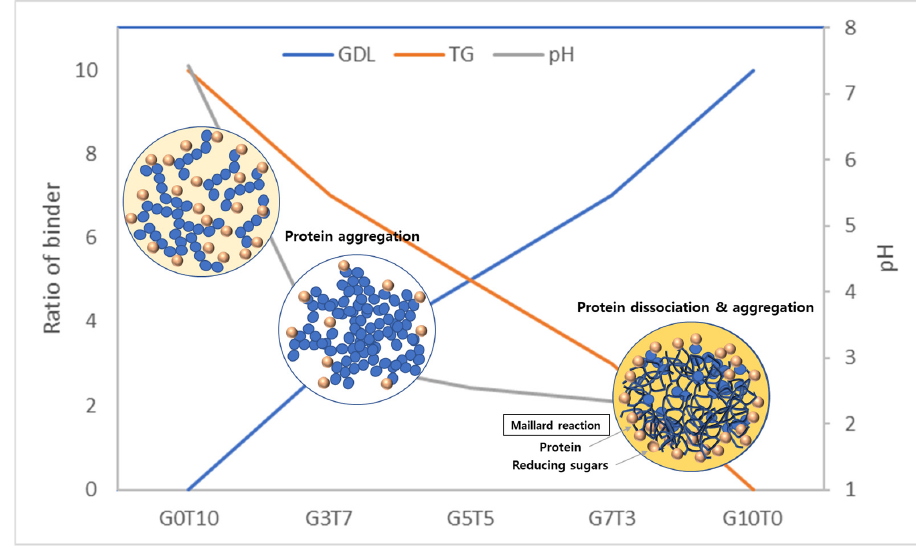
Figure 6. Color and structure change of soy protein depends on the binder ratio.